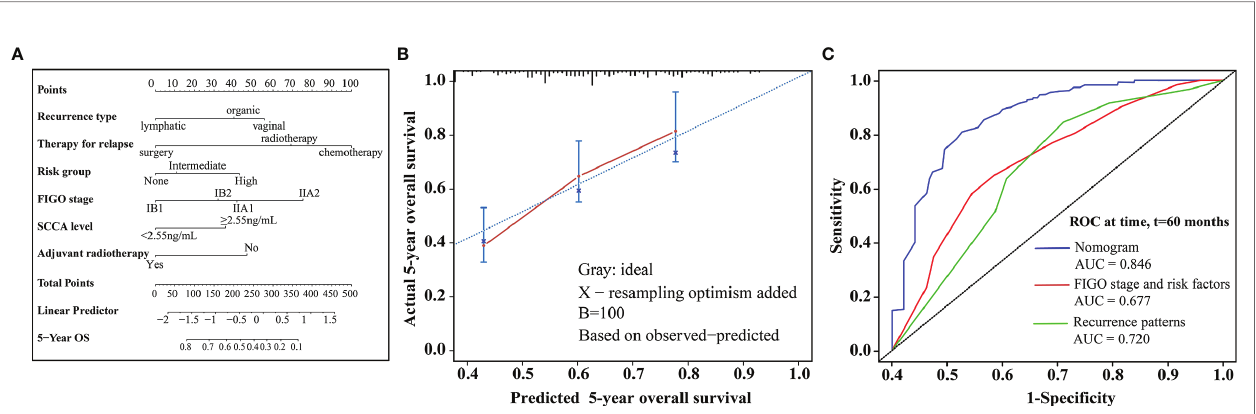
FIGURE 2 | (A) Nomogram predicting 5-year OS rates for patients with relapse after initial treatment. The nomogram was based on scores corresponding to each independent variable. The total score (bottom of the scale) indicates the probabilities of 5-year OS rates. (B) The predicted and observed 5-year OS rates were used for model calibration. The x-axis displays nomogram-predicted probability, while the y-axis displays observed survival rates estimated using the Kaplan-Meier method. The dotted line indicates excellent model calibration, with good concordance between the predicted and observed survival rates. The vertical bars represent 95% con fi dence intervals. (C) Receiver operating characteristic curves with area under the curve values compare nomogram and traditional model discrimination. The blue lines represent survival rates predicted by the